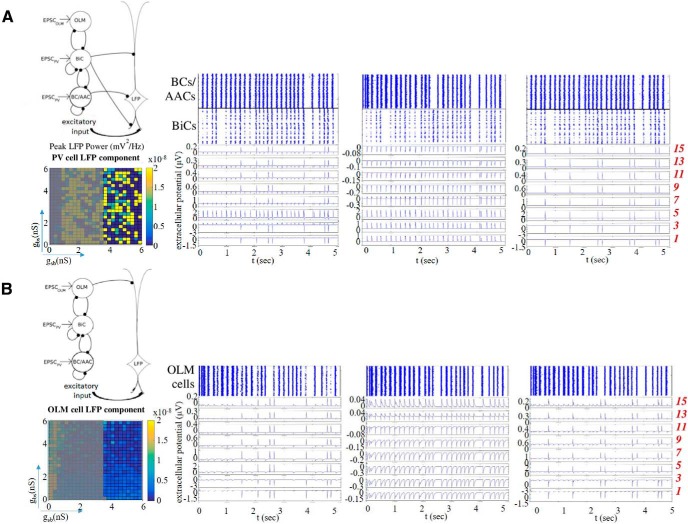
LFP pattern examples in predicted regime when only either PV or OLM cell populations are present. Peak power color plots as in Figure 7 are shown but with a different color resolution. A gray overlay is added to the plots to emphasize the predicted regime. Three examples of LFP responses (5 s) across the different layers are shown to illustrate the different patterns observed. For each example, spike rasters for the particular example are shown for PV cells (BiCs and BC/AACs) or OLM cells. A, PV cell LFP component. B, OLM cell LFP component. Parameter values for left, middle and right columns are, respectively, (gsb, gbs) = (5, 2.75), (5.5, 0.5), (5.75, 1) nS.